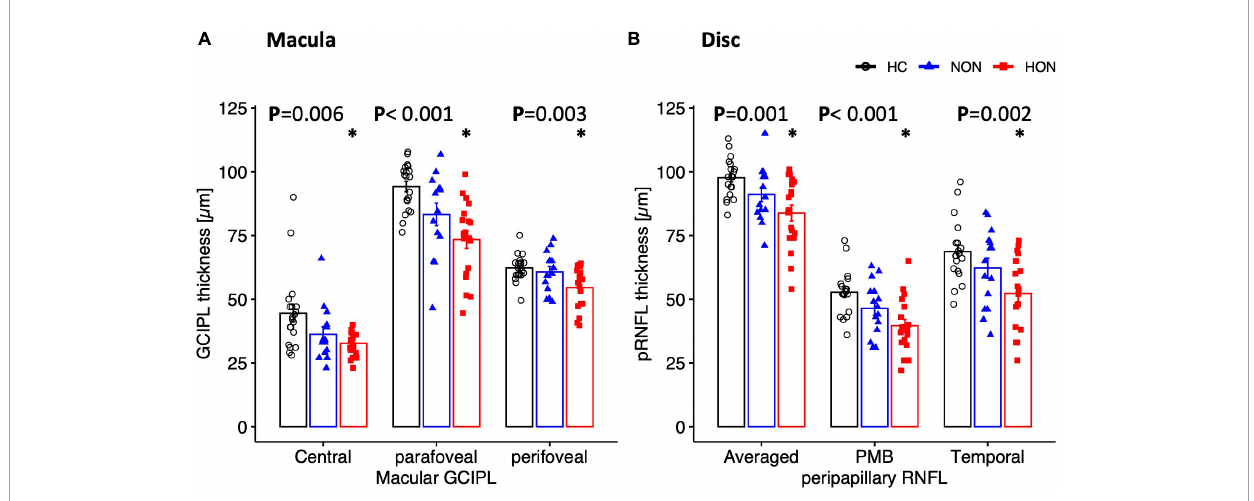
FIGURE4 Structural measures of macula (A) and peripapillary (B) areas depicted as mean ± SEM. Ganglion cell inner plexiform layer thickness of the macula is significantly reduced in HON in the three scanned regions. Peripapillary retinal nerve fiber layer thickness (pRNFL), mainly the temporal sector and papillomacular bundle as well as the averaged thickness, is significantly reduced only in HON. *Indicates significant HON vs. HC